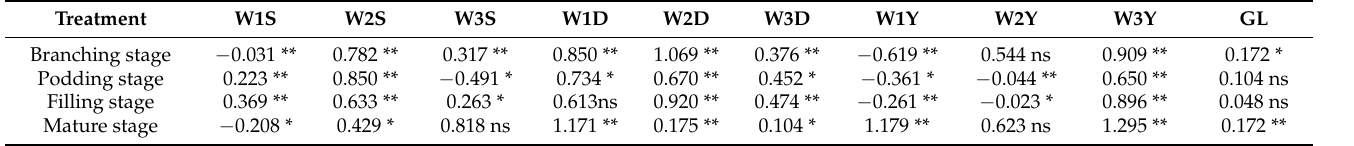
Table 3. Slope analysis of soil water content and distance from tree at each growth